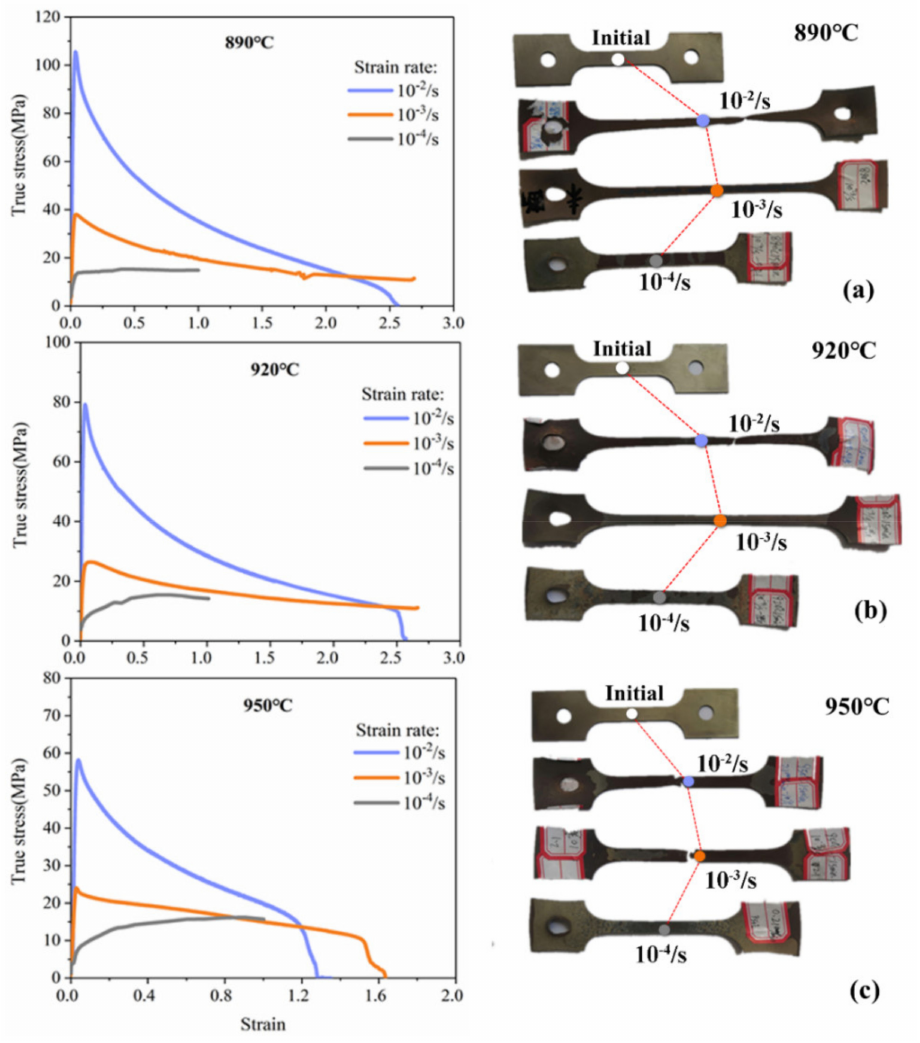
Figure 3. Specimens and flow stresses before and after testing: ( a ) 890 ◦ C; ( b ) 920 ◦ C; ( c ) 950 ◦